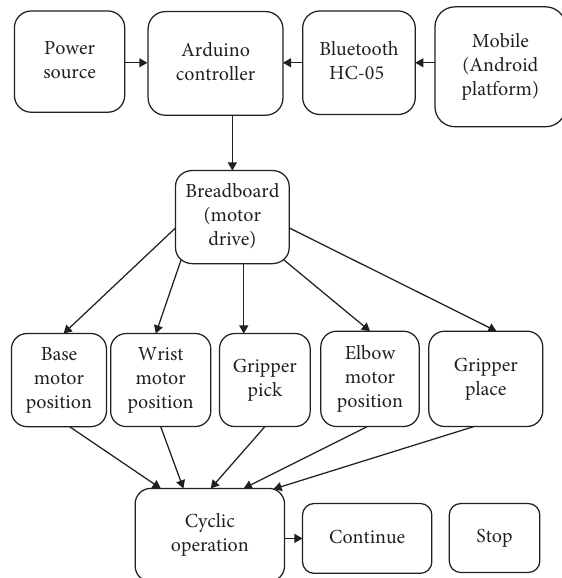
Figure 10: Application deployment